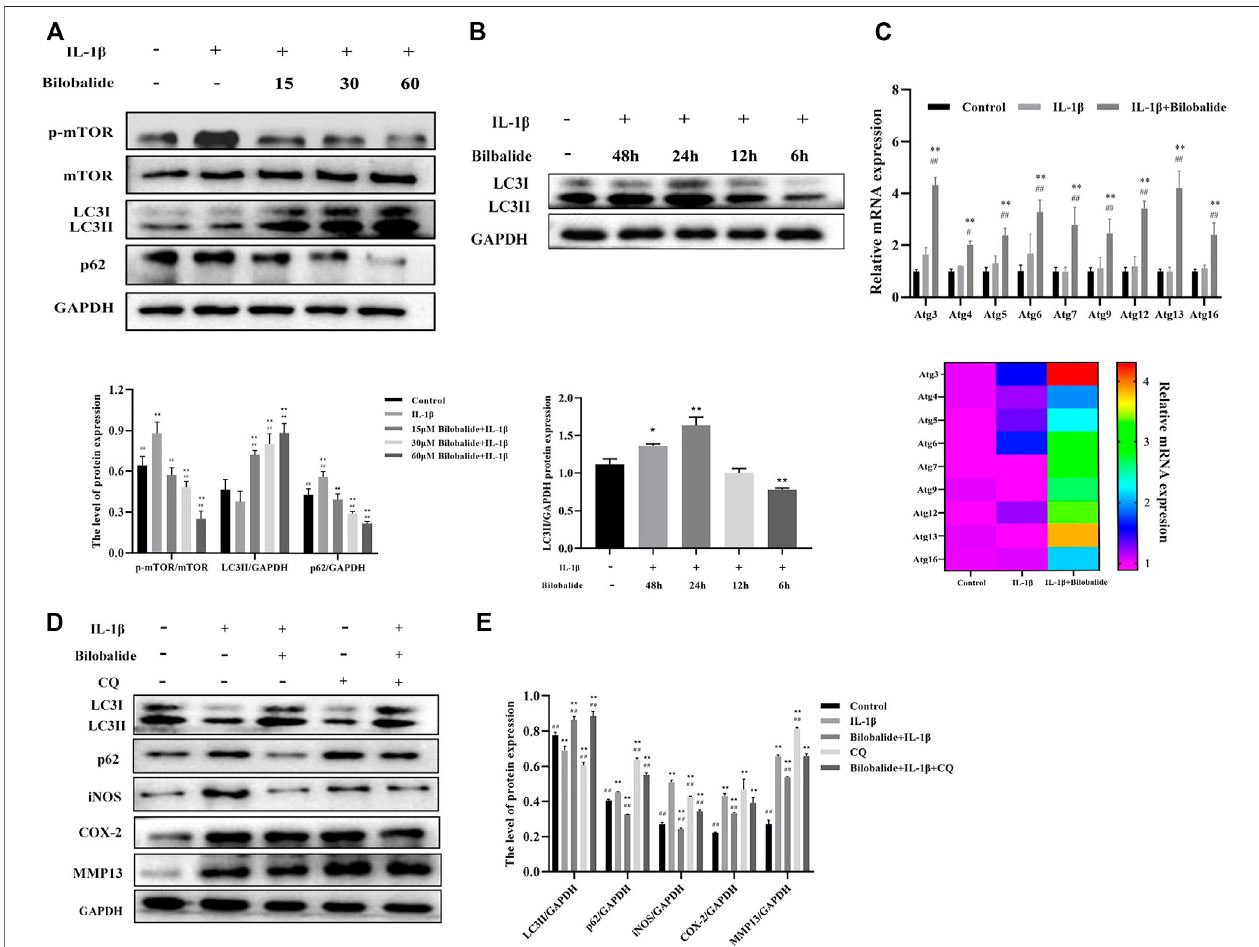
FIGURE 4 | The effect of bilobalide on autophagy in ATDC5 chondrocytes induced by IL-1 β . (A) Western blot analysis of mTOR, p-mTOR, LC3II, and p62 protein expression after treatment with 10 ng/ml IL-1 β and different concentrations bilobalide for 24 h. (B) The effect of 60 μ M bilobalide with different incubation periods in the presence of 10 ng/ml IL-1 β on autophagy was determined through the LC3II protein using western blot. (C) The expression levels of certain autophagy-related genes (Atggenes)wereevaluatedusingqPCR. (D,E) Chondrocyteswerepretreatedwith30 μ MCQ.TheproteinlevelsofLC3II,p62,COX-2,andMMP13wereexamined byWesternblot.Alldatawerepresentedasmean±SD( n =3).* p < .05and** p < .01comparedtothecontrolgroup; # p < .05and ## p < .01comparedtotheIL-1 β group (Statistical analysis using one-way ANOVA, two-way ANOVA, paired two-tailed Student ’ s t-test, and unpaired two-tailed Student ’ s t-test).